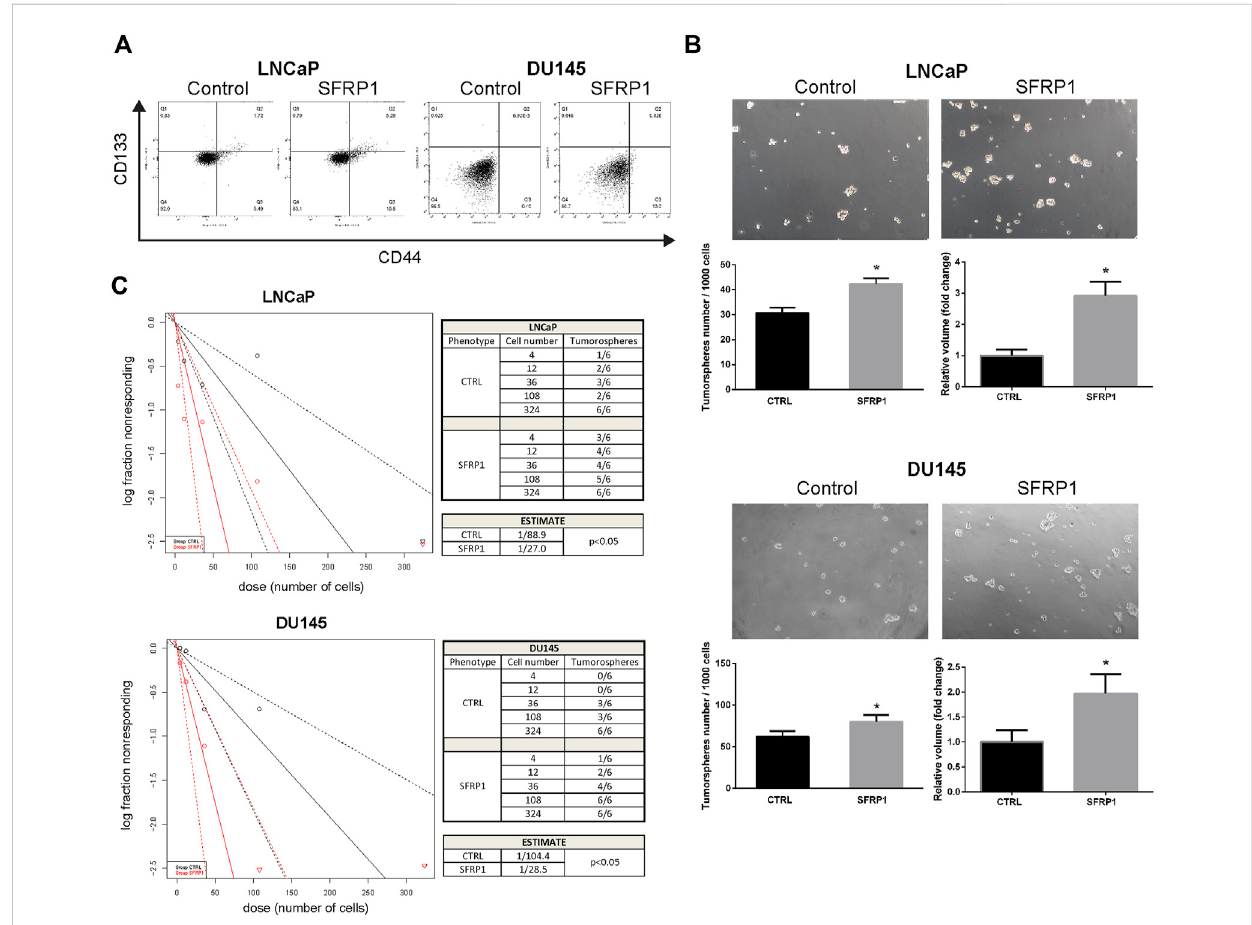
FIGURE 3 (A) Flow cytometryanalysis of the CD44+/CD133+ subpopulation in cells treated with SFRP1 or vehicle. (B) Representative images of tumorspheres formed in LNCaP and DU145 cells treated with SFRP1 or vehicle; tumorspheres were counted from 1,000 seeding cells, and the volume was calculated with the equation V = 4/3 π r³ (* p < 0.05). (C) The χ 2 tests were calculated using ELDA software to evaluate the frequency of PCSCs. The number of cells plated is displayed against the log proportion of wells devoid of tumorspheres. The tables illustrates the estimated frequency of